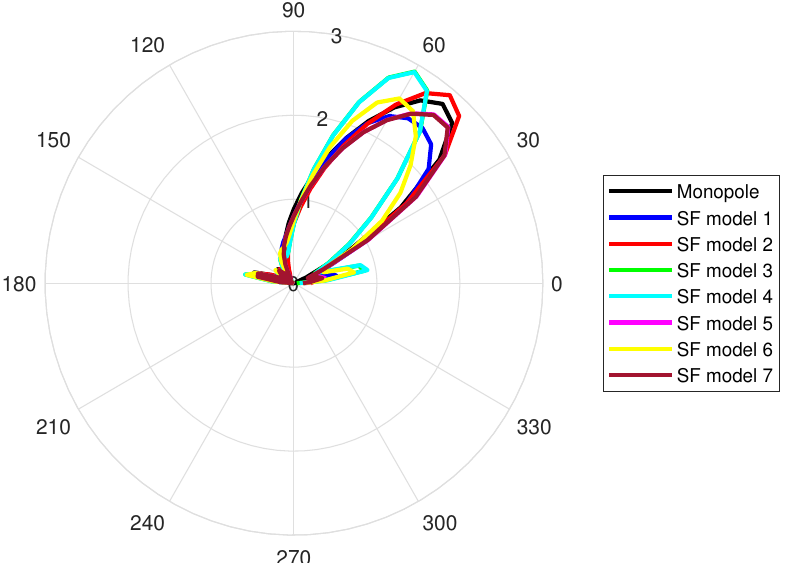
Figure 7. Directivity of the antennas at the resonance frequency in spherical coordinates at φ = 0.